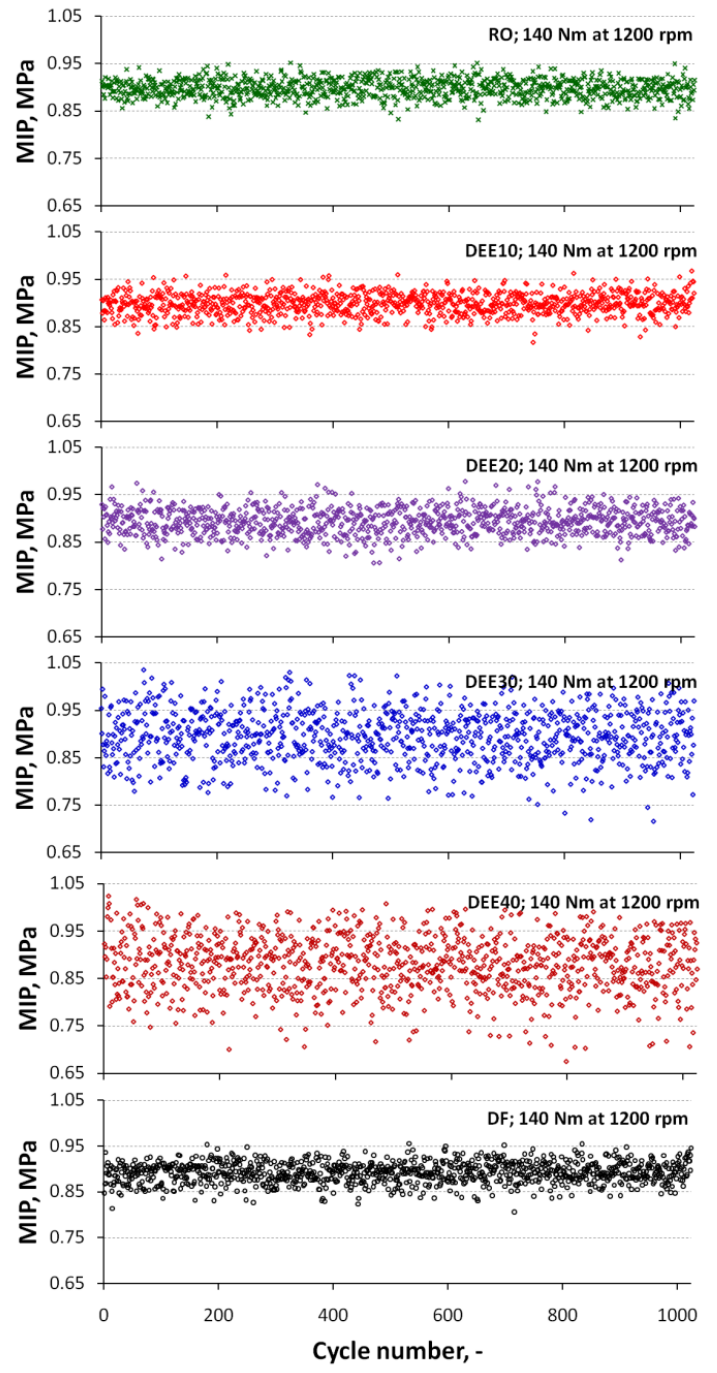
Figure 6. MIP calculated for 1024 consecutive cycles recorded for the AD3.152 engine fueled with tested fuels, operated with 140 Nm at 1200 rpm.